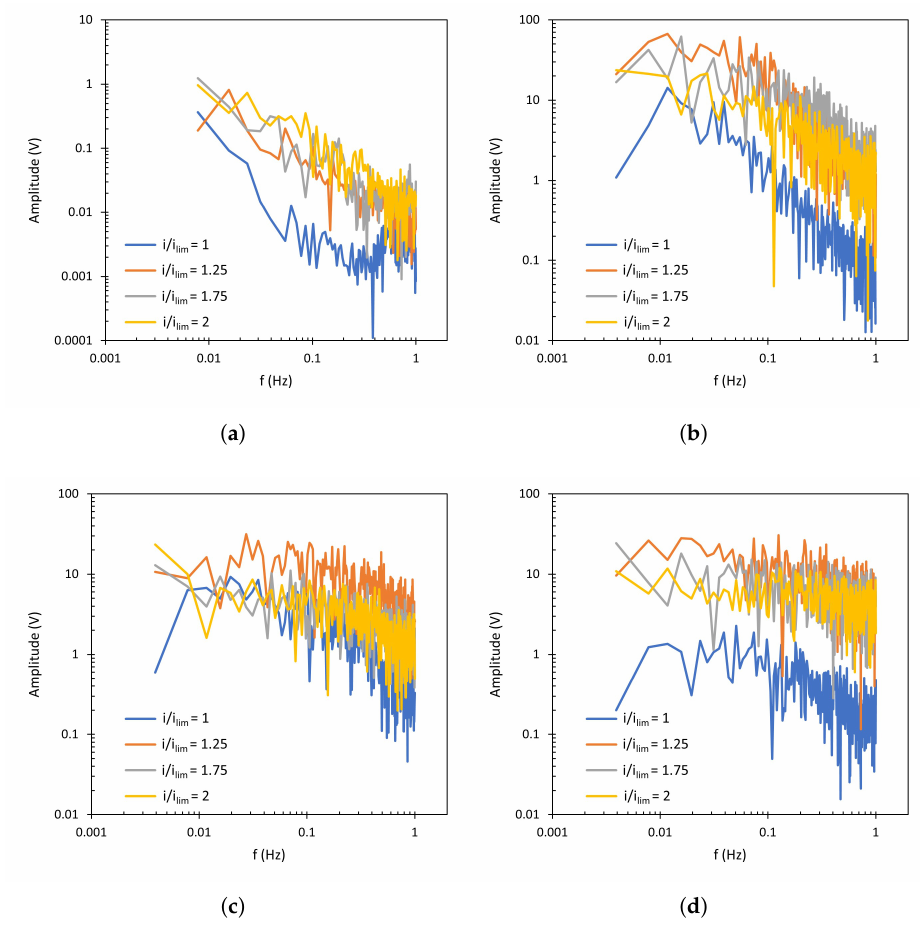
Figure 7. Fourier Transform of the membrane AMV-N at ( a ) 0 rpm, ( b ) 200 rpm, ( c ) 400 rpm, ( d ) 600